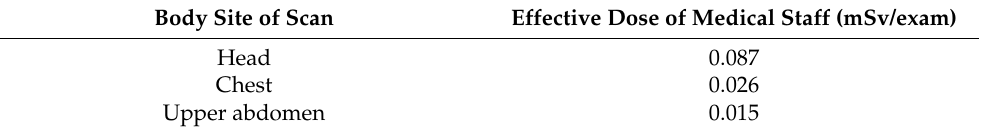
Table 2. Estimated effective dose exposure of the medical staff in each scan.